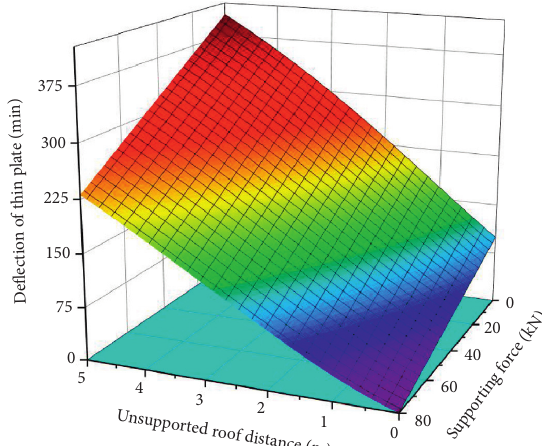
Figure 7: The response surface of roof deflection and deformation under unsupported roof distance and supporting